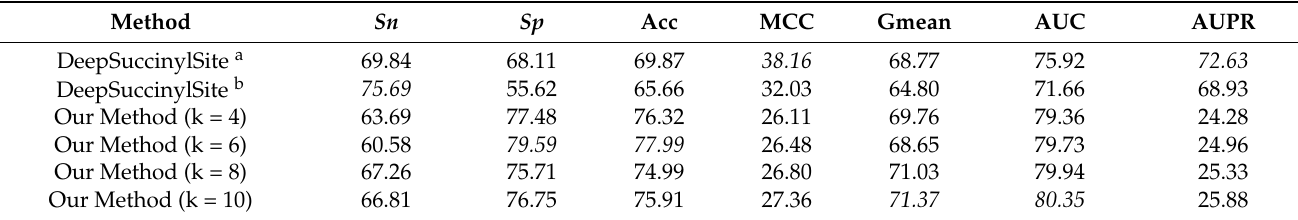
Table 2. The k-fold cross-validation performance of our method vs. DeepSuccinylSite (the data are percentages). DeepSuc- cinylSite a and DeepSuccinylSite b denote DeepSuccinylSite with one-hot encoding and embedding encoding. The highest value in each category is shown in